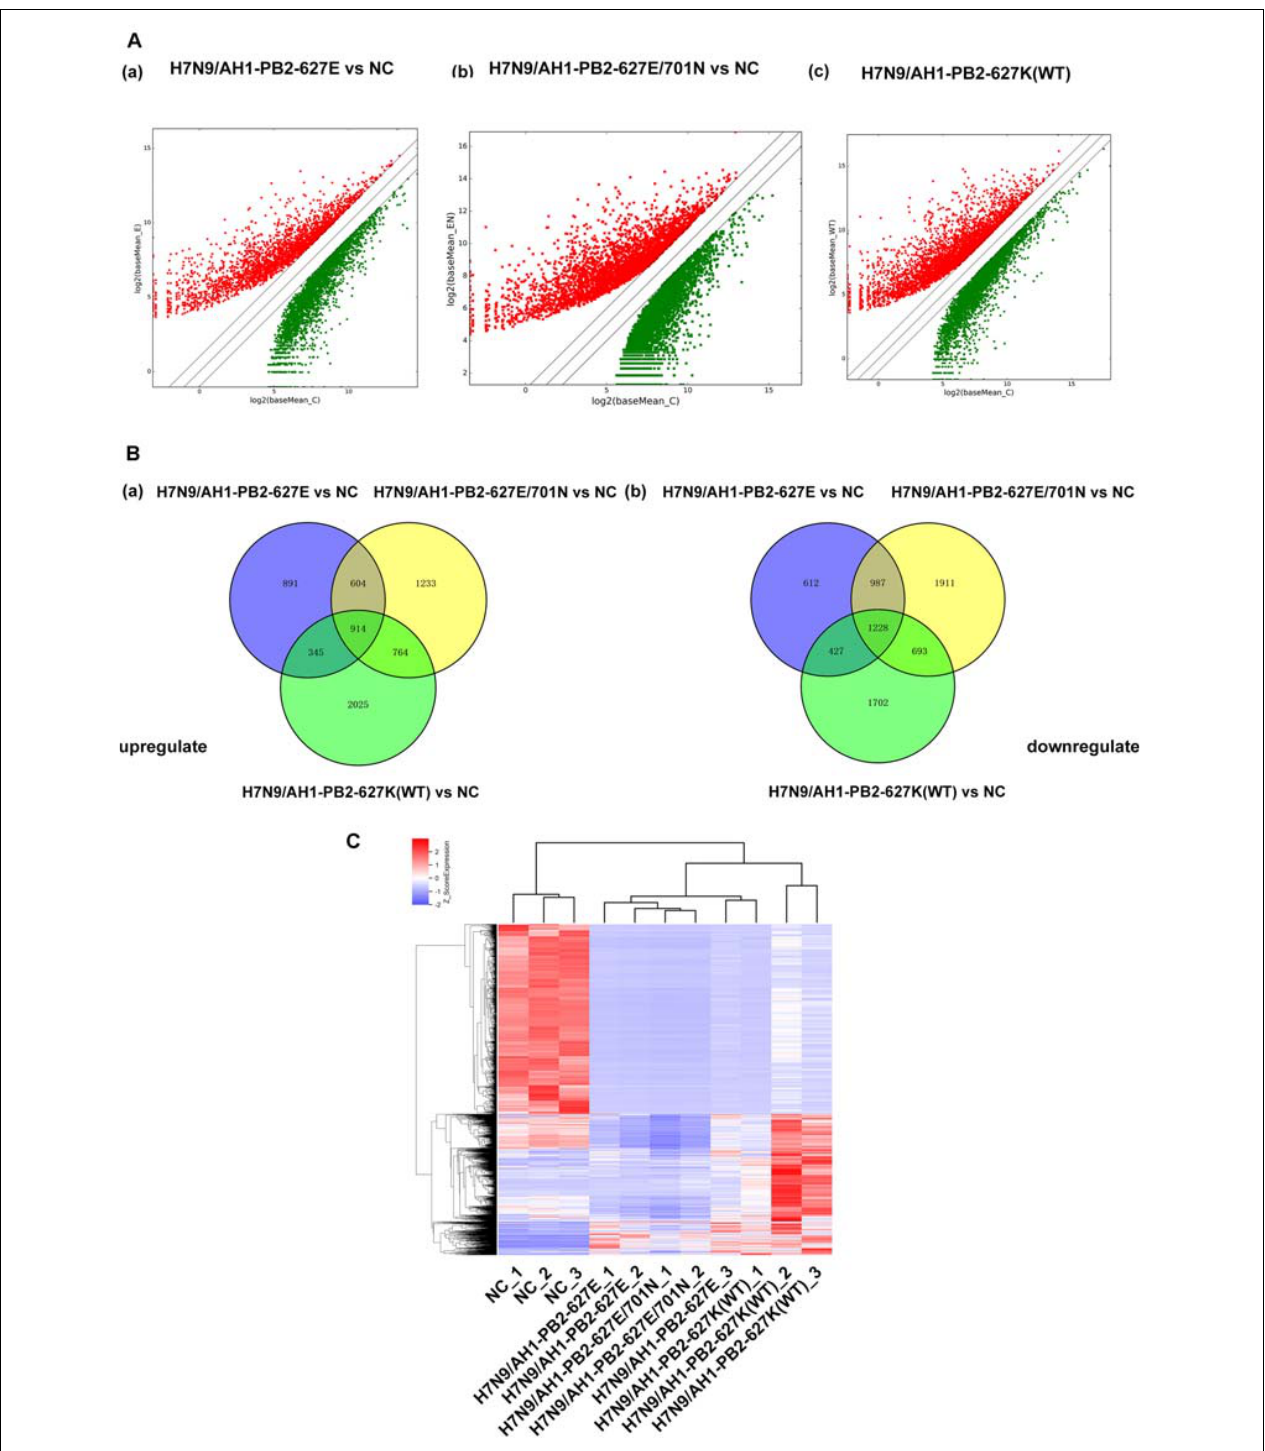
FIGURE 4 | Global analysis of mRNA expression profiles in mouse lung infected with H7N9/AH1-PB2-627K(WT) and its mutant influenza viruses compared with negative control group (NC). (A) The scatter diagram showing the distribution of differential expression of mRNAs in different influenza virus infected groups relative to the NC group. Red and green dots represent up- and down-regulated differentially expressed mRNAs, respectively. (B) The Venn diagram shows the number of common and specific differentially expressed mRNAs in the three influenza virus infected groups: H7N9/AH1-PB2-627E vs. NC (blue circle), H7N9/AH1-PB2-627E/701N vs. NC (yellow circle), H7N9/AH1-PB2-627K(WT) vs. NC (green circle). (C) Hierarchical clustering depicts the common differentially expressed mRNAs compared with negative control group.